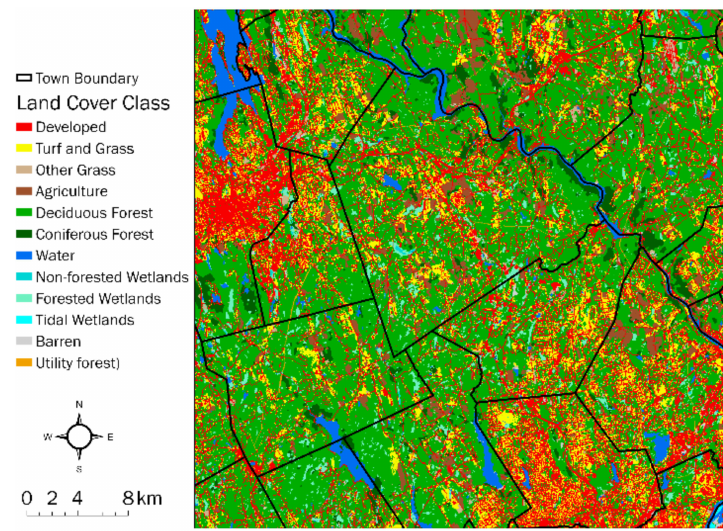
Figure 1. 2015 Connecticut’s Changing Landscape land cover map for a multi-town area, about 30 km 2 .